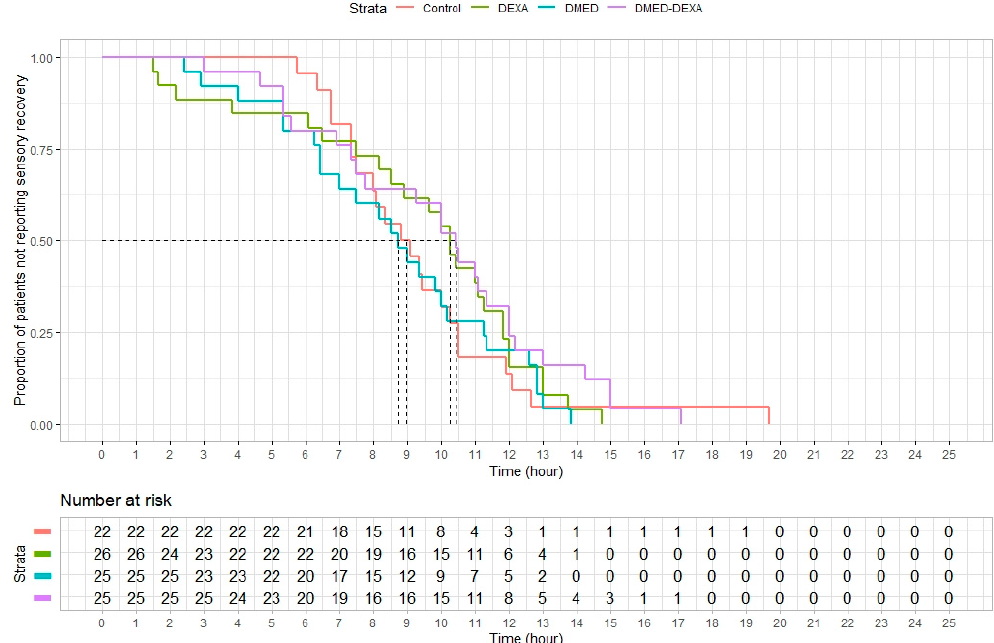
Figure A1. Survival analysis of the duration of sensory blockade. The crossing points of the dotted and colored solid lines indicate median duration of the corresponding strata (groups). There was no difference in sensory block duration ( p = 0.430).